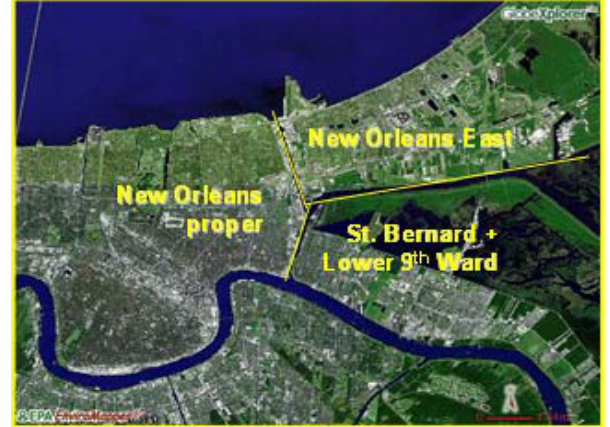
Figure 2: Map of New Orleans and neighboring areas showing the partitioning of the pump-out. Flood waters from New Orleans proper and New Orleans East were largely pumped into Lake Pontchartrain. Flood water from St. Bernard Parish and the Lower Ninth Ward of New Orleans were largely pumped into Violet Marsh.